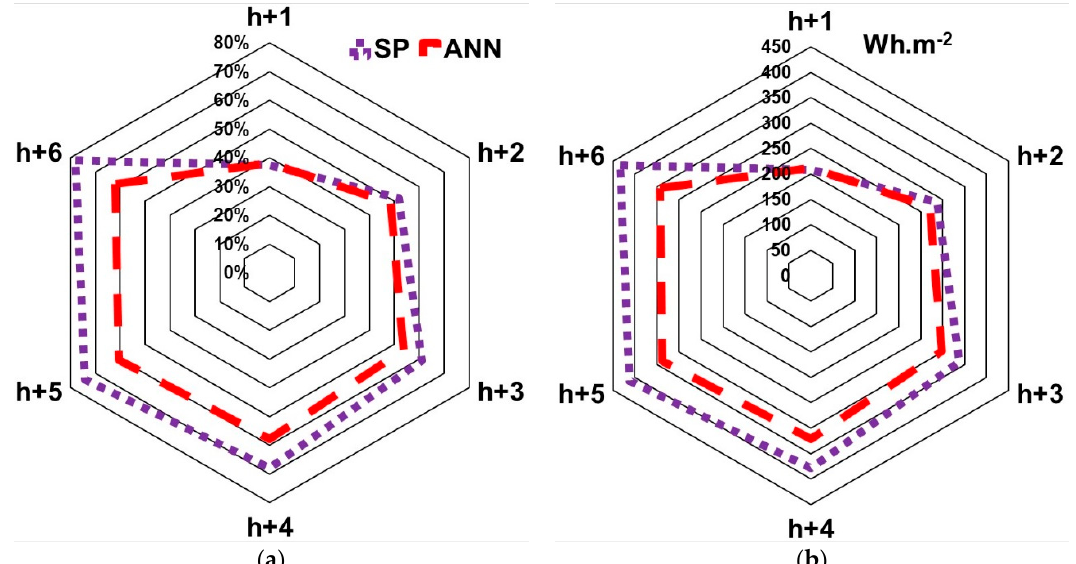
Figure 11. Comparison of forecasting models for various horizons for hourly DNI (Odeillo site); ( a ) in terms of nRMSE; ( b ) in term of RMSE.